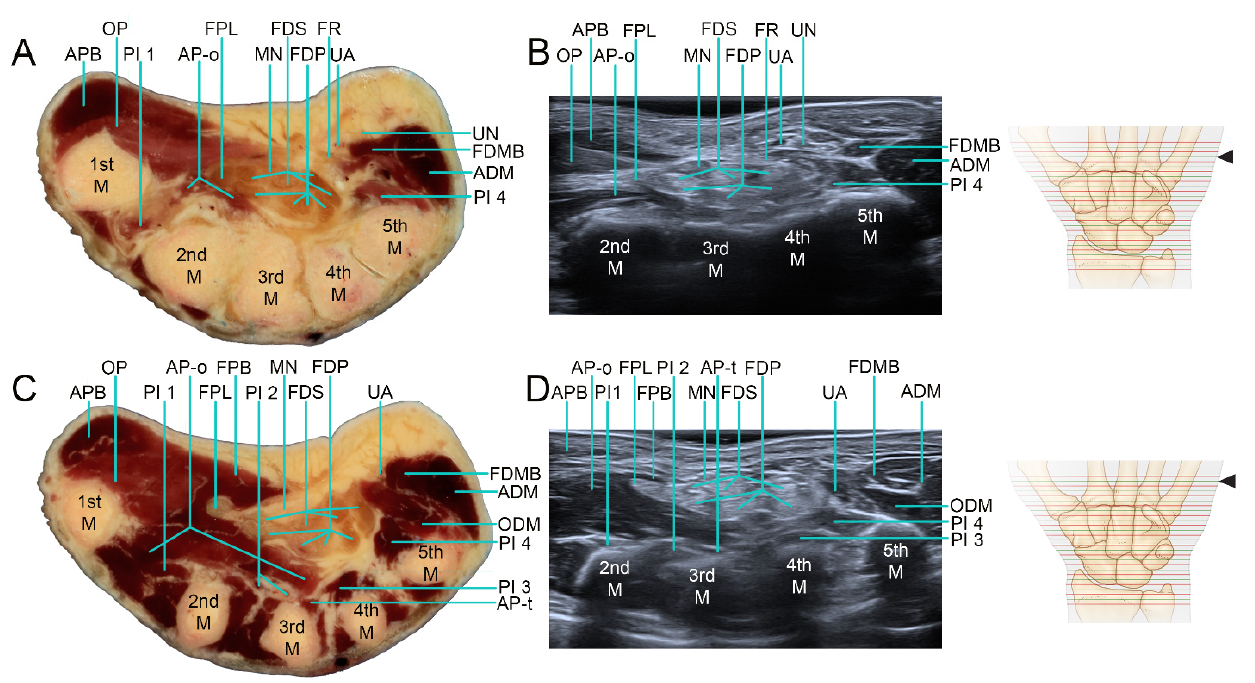
Figure 9. Sectioned images ( A , C ) and the corresponding US ( B , D ) images for transverse views at the distal part of the metacarpal bases. ( A , B ) The metacarpals are observed. The thenar (APB and OP) and hypothenar (FDMB and ADM) muscles become thicker. The APB and OP extend to the FR. The oblique head of the adductor pollicis (AP-o) is anterior to the second metacarpal. The FPL tendon is round and is slightly prominent toward the radial side. The MN is between the second and third FDS tendons. The UA is just radial to the FDMB, and the UN is anterior to the FDMB. The first palmar interosseous muscle (PI 1) is between the first and second metacarpals, and the fourth palmar interosseous muscle (PI 4) is anterior to the fifth metacarpal. ( C , D ) At a more-distal level, the metacarpals decrease in size, and the interosseous muscles are between the metacarpals. The hypothenar muscles (FDMB and ADM) become thicker. The second and third FDS and FDP tendons are slightly separated from their corresponding fourth and fifth tendons. The FPL tendon is slightly separated from the FDS and FDP tendons, moving toward the radial side. The MN is between the second and third FDS tendons. The OP becomes thicker, and the AP-o becomes thicker and extends to the third metacarpal. The flexor pollicis brevis (FPB) appears on the ulnar side of the APB. The MN is between the second and third FDS tendons. The UA is radial to the FDMB and superficial to the opponens digiti minimi (ODM). PI 2, second palmar interosseous muscle; PI 3, third palmar interosseous muscle; AP-t, transverse head of the adductor pollicis. Arrowheads in the schematics indicate the levels of the wrist scanned by the US transducer.